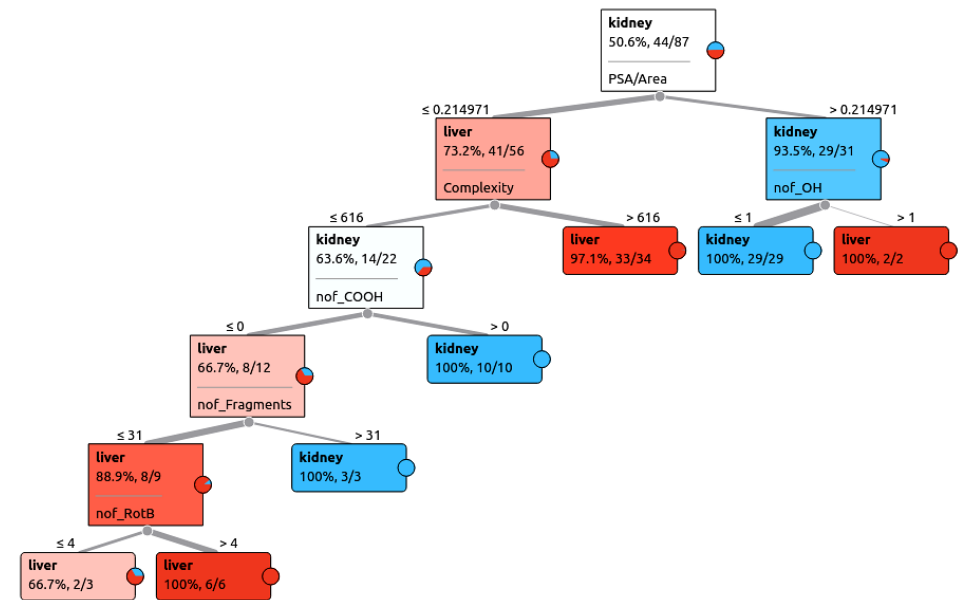
Figure 4. Decision tree used to classify drug interaction with liver OATPs vs kidney OATs based on chosen features. An example of one of the several decision trees generated is shown above. A few of the terminal nodes were examined to determine whether these pure or almost pure nodes contained chemically similar pharmaceuticals as measured by Tanimoto similarity (Supplementary Materials Figure